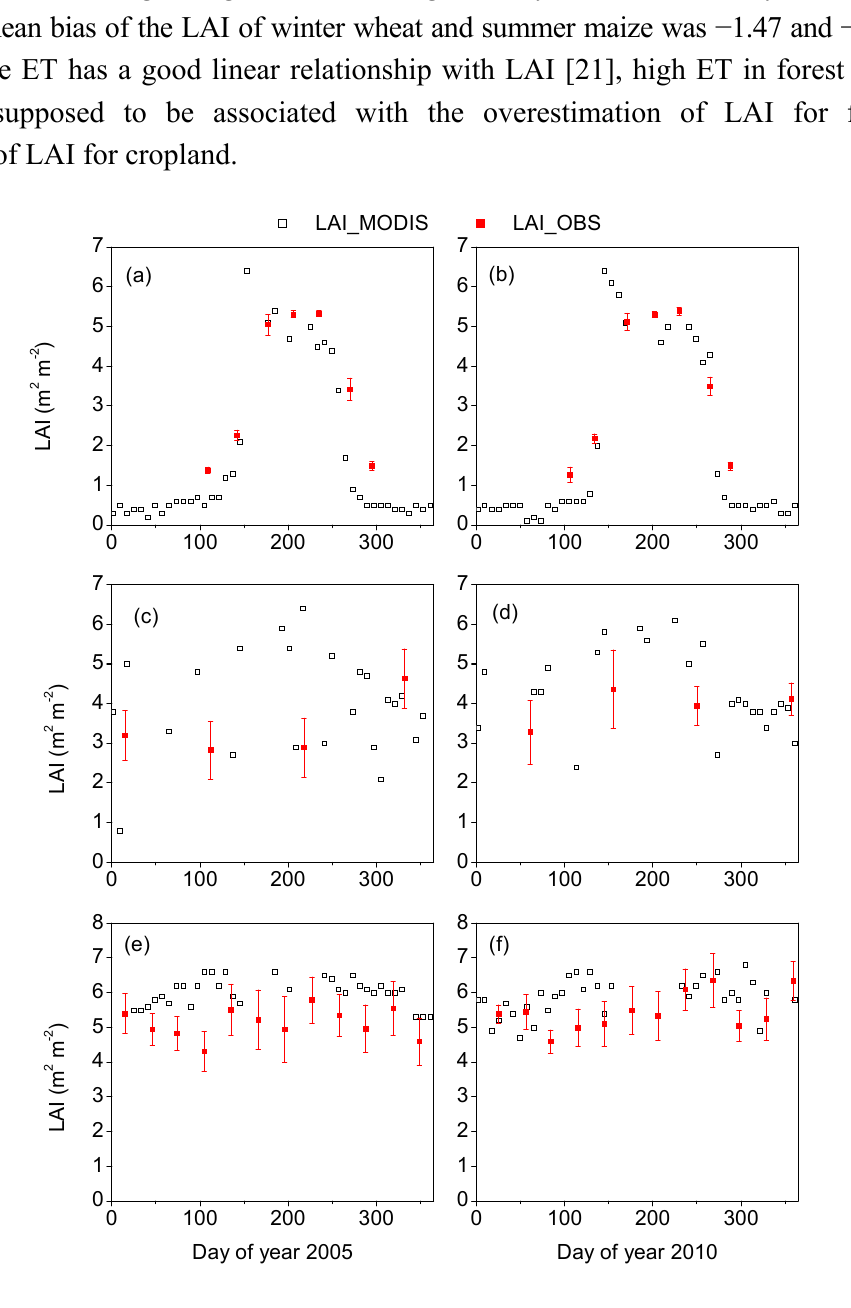
Figure 3. Comparison of MODIS and observed leaf area index (LAI) at the ( a , b ) Changbaishan (CBS), ( c , d ) Dinghushan (DHS) and ( e , f ) Xishuangbanna (XSBN) forest